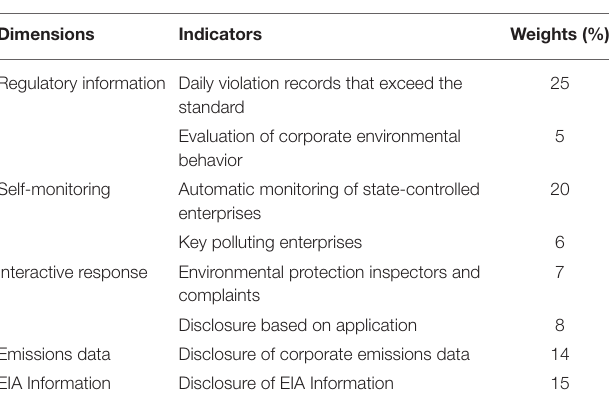
TABLE 2 | Accounting standards of PITI.